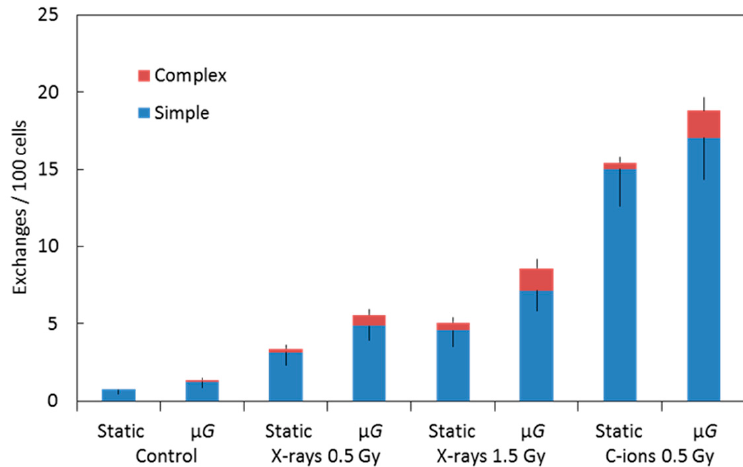
Figure 3. Graphic representation of the data shown in Table 1. Frequencies of simple and complex types of chromosome exchanges induced by X-ray or C-ion beam while cells were under either static or simulated µ G conditions. Error bars indicate the standard error of the mean values.